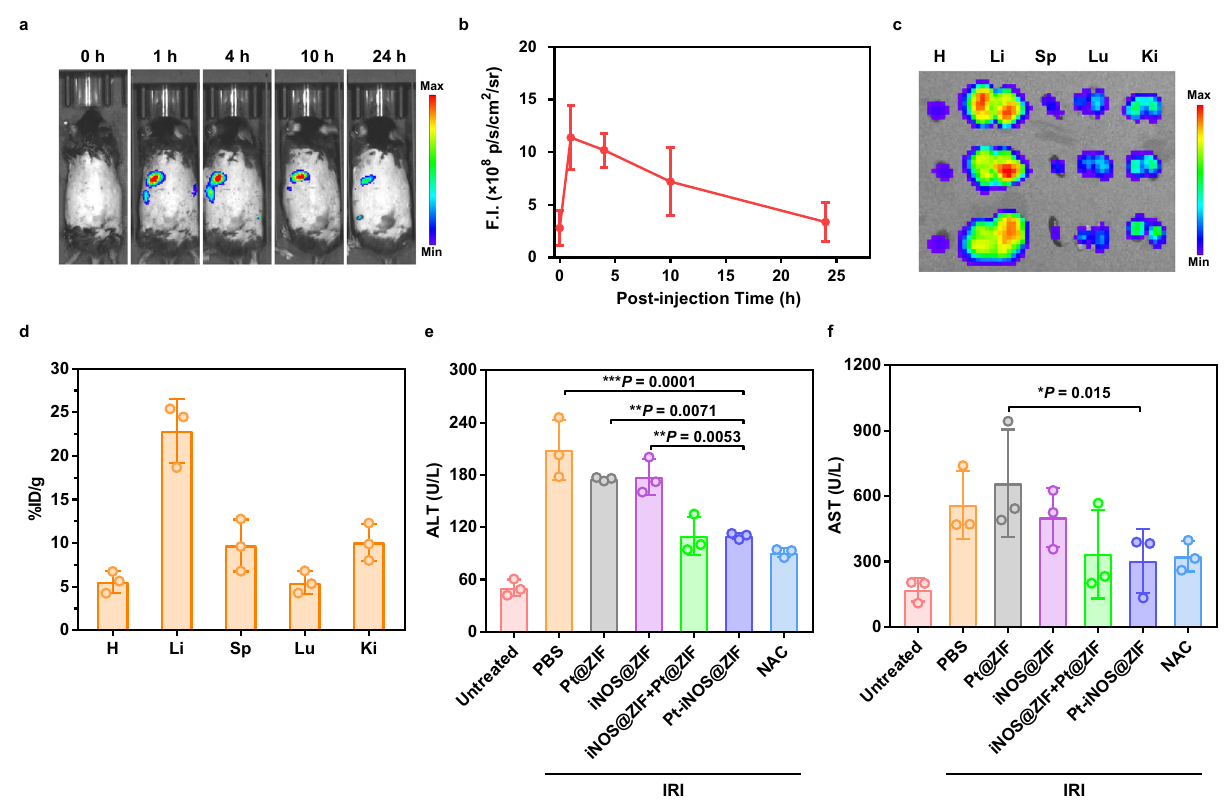
Fig. 5 In vivo performance. a Representative in vivo fl uorescence images of C57BL/6 mice at 1, 4, 10, and 24 h p.i. of Pt-iNOS@ZIF ( n = 3). b Quantitative ROI assays of the fl uorescence intensity in mice at designated time points. c Ex vivo fl uorescence images of major organs at 24 h p.i. H: heart, Li: liver, Sp: spleen, Lu: lung, Ki: kidney. d Biodistribution of Pt-iNOS@ZIF in major organs at 24 h p.i. evaluated by ICP-OES. e , f Serum ALT and AST levels in mice after 60 min of ischemia and 12 h of reperfusion from each group. For 5 b , d – f , n = 3 biologically independent animals. Data presented as means ± s.d. P values were calculated by ANOVA F -test, each comparison stands alone. * P < 0.05; ** P < 0.01, *** P <